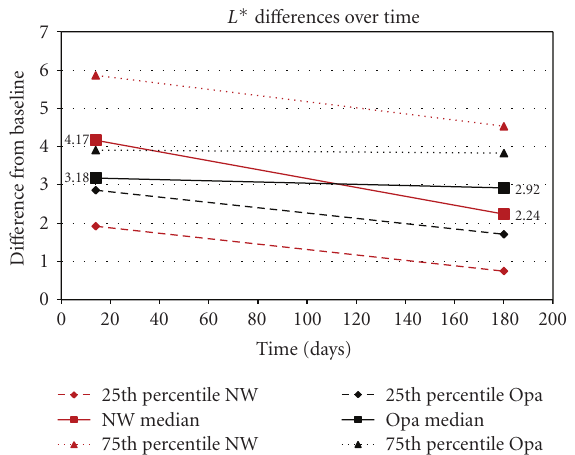
Figure 2: Opalescence (Opa) and Nite White (NW). The 25th percentile, median, and 75th percentile di ff erences in the a ∗ values between the baseline (before treatment) and after treatment (14 days) and between baseline and after 6